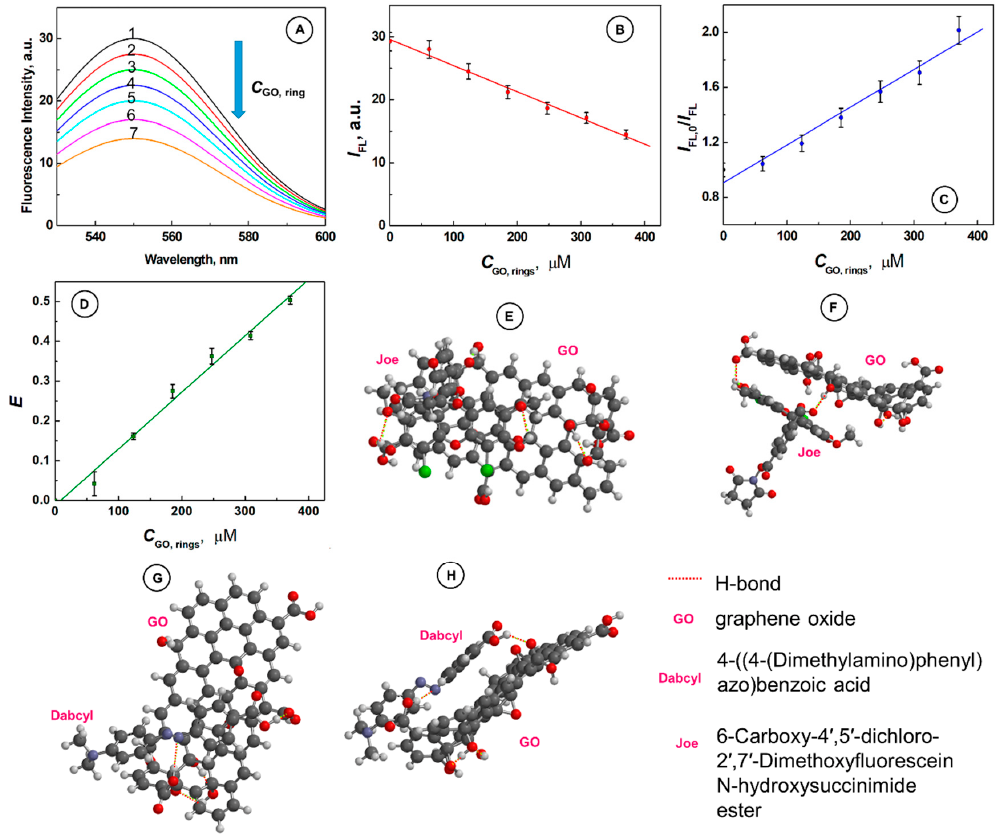
Figure 2. ( A ) Fluorescence spectra for SurMB-Joe after addition of GO at different concentrations C GO,rings (µM): (1) 0, (2) 61.8, (3) 123.5, (4) 185.4, (5) 247.3, (6) 308.9, (7) 380.8; ( B ) dependence of I FL vs. C GO,rings ; ( C ) Stern–Volmer plot of I FL,0 / I FL vs. C GO,rings ; ( D ) dependence of quenching efficiency E on C GO,rings ; ( E ) top and ( F ) side views of GO-Joe supramolecular structures with H-bonds marked with red dashed lines; ( G ) top and ( H ) side views of GO-Dabcyl supramolecular structures with H-bonds marked with red dashed lines. Joe: 6-Carboxy-4 (cid:48) ,5 (cid:48) -dichloro-2 (cid:48) ,7 (cid:48) -dimethoxyfluorescein N-hydroxysuccinimide ester; Dabcyl: 4-((4-(Dimethylamino)phenyl) azo) benzoic acid. Conditions: C SurMB = 100 nM; buffer: 10 mM PBS, pH 7.4; room